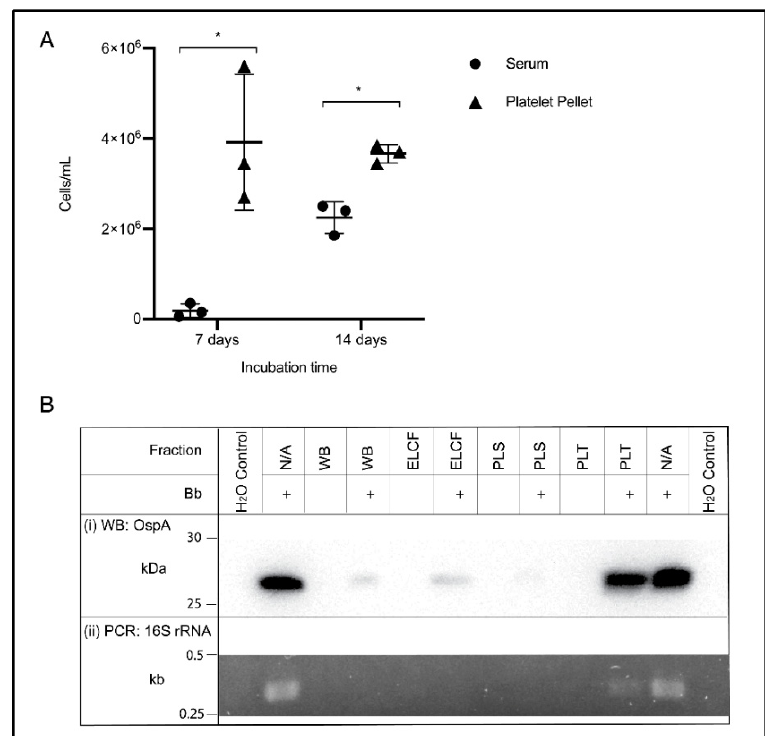
Figure 6. Culture and molecular detection of Borrelia in blood fractions. ( A ) Broth culture of serum and platelet fractions collected from experimentally infected blood samples, monitored weekly for growth. Data represented as the means with standard deviation. Asterisks indicate significant di ff erence by one-tailed paired t -test (* = p < 0.05) ( n = 3). ( B ) Detection of OspA protein by Western blot (i) and the 16S rRNA gene by PCR (ii) in experimentally infected and matched uninfected blood, and controls. WB = whole blood, ELCF = erythrocyte, leukocyte cellular fraction, PLS = plasma, and PLT = platelet